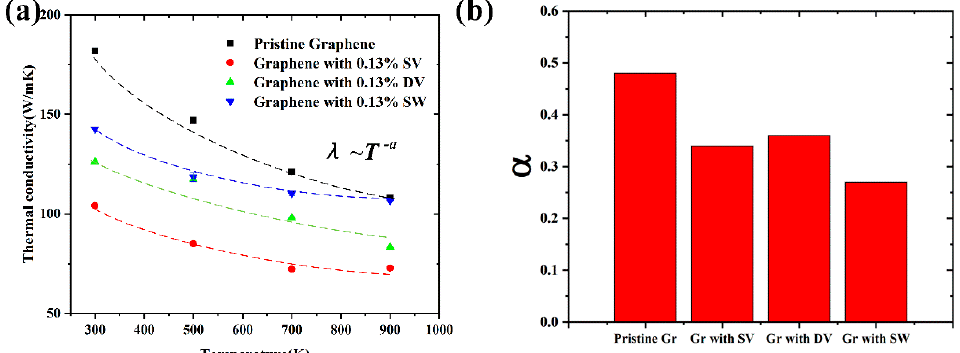
Figure 14. ( a ) The TCs of Gr with/without defect at different temperature; and ( b ) the corresponding power law index α .